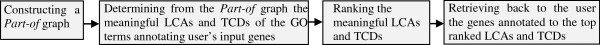
A graphical representation of our approach showing the sequential processing steps for answering a query.